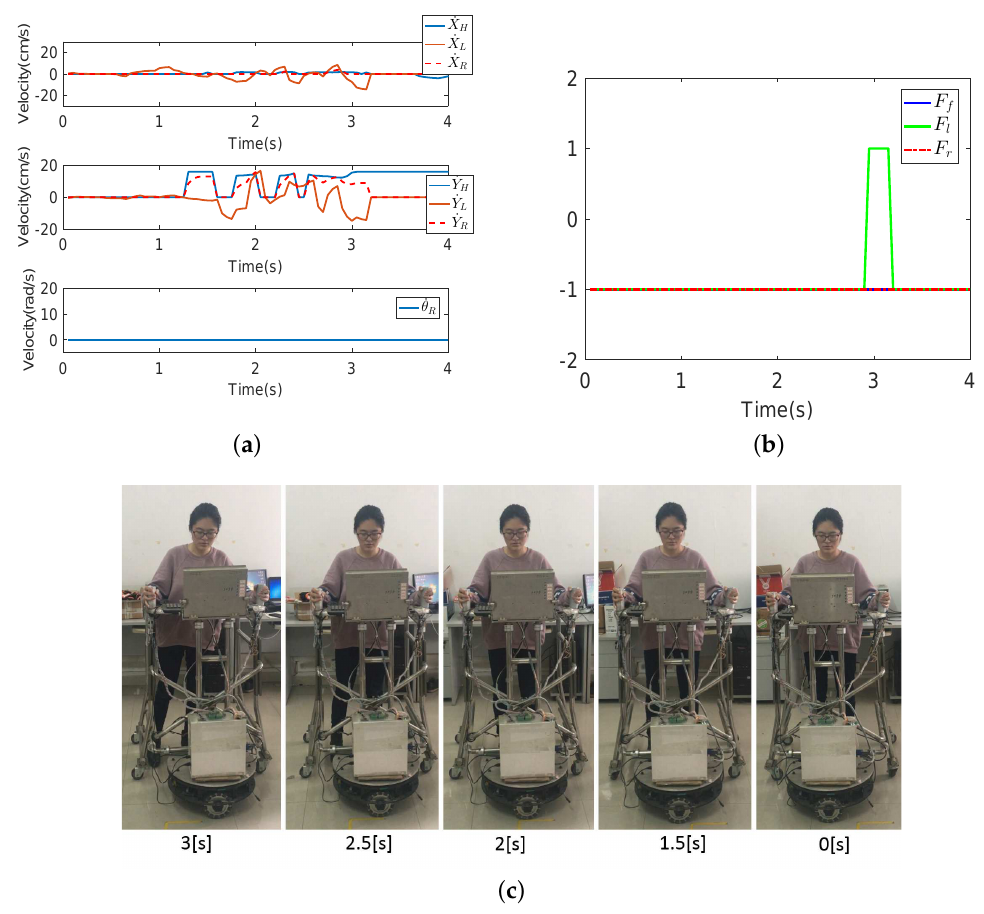
Figure 14. The results of the falling to the left experiment. ( a ) The HMI velocities estimated by HMI Estimation Algorithms I and II and the actual robot moving velocities by the KF-based coordinated motion fusion algorithm when the subject falls to the left. ( b ) The result of fall mode detection when the subject falls to the left. ( c ) The process of falling to the